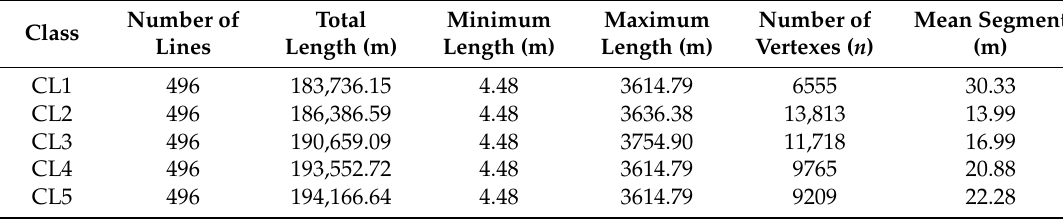
Figure 3. Datasets of lines used in the application: ( a ) general view; ( b ) Zoom view showing the 5 morphology classes (CL1 to CL5) for a sample of several lines. Table 1. Main characteristics of the datasets of lines.